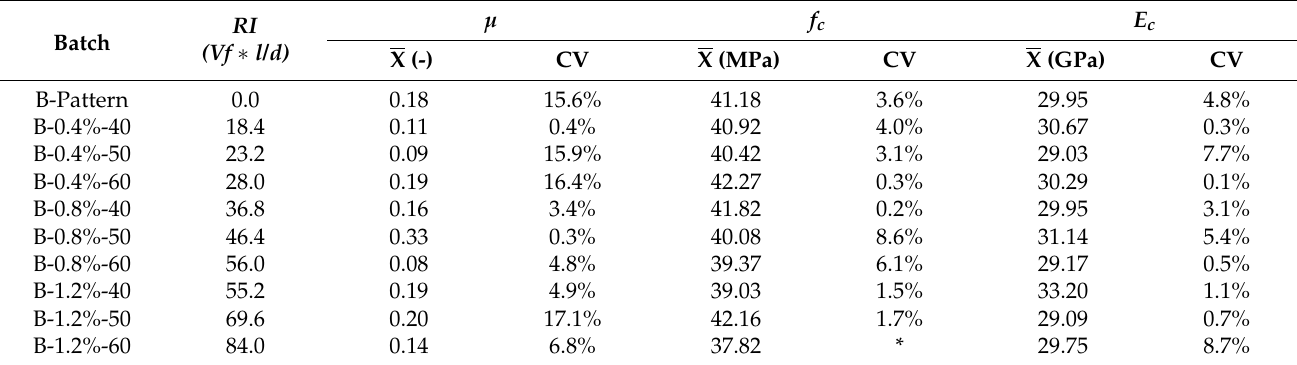
Table 3. Mechanical properties of fiber-reinforced concrete.